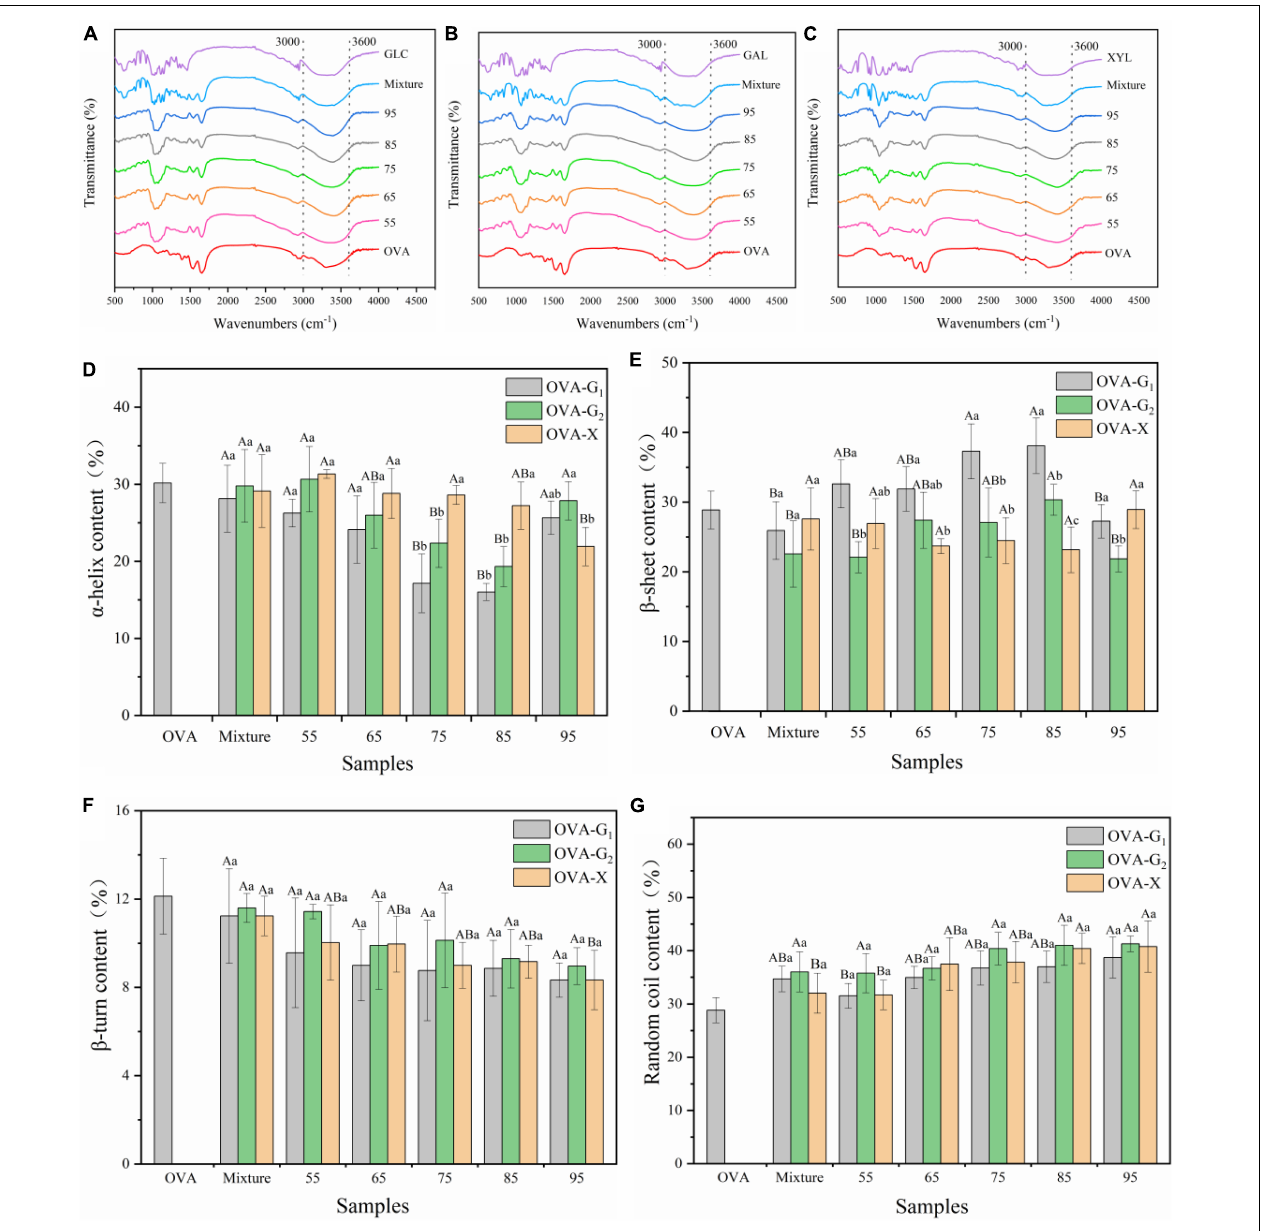
FIGURE 2 | Functional groups changes (A–C) and secondary structure content (D–G) of OVA, OVA-G 1 , OVA-G 2 , and OVA-X at different reaction temperatures. Different capital letters indicate significant differences ( P < 0.05) in OVA, Mixture, and OVA-monosaccharide conjugates formed at different reaction temperatures each monosaccharide. Different lowercase letters indicate significant differences ( P < 0.05) between OVA-monosaccharide conjugates of different sugar types.Mixture: the mixture of Ovalbumin and glucose/galactose/xylose with no